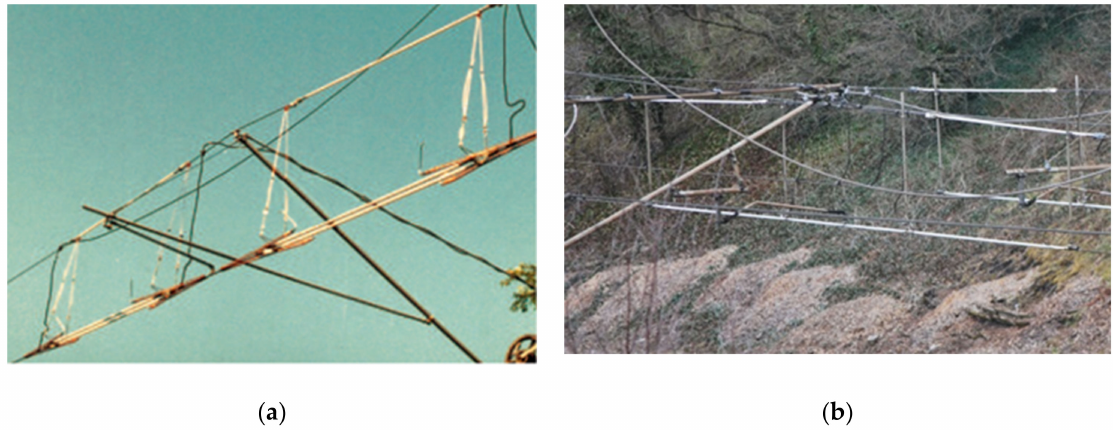
Figure 5. Arthur Flury twin rod neutral section ( a ), source Arthur Flury [13] and single rod ( b ), source